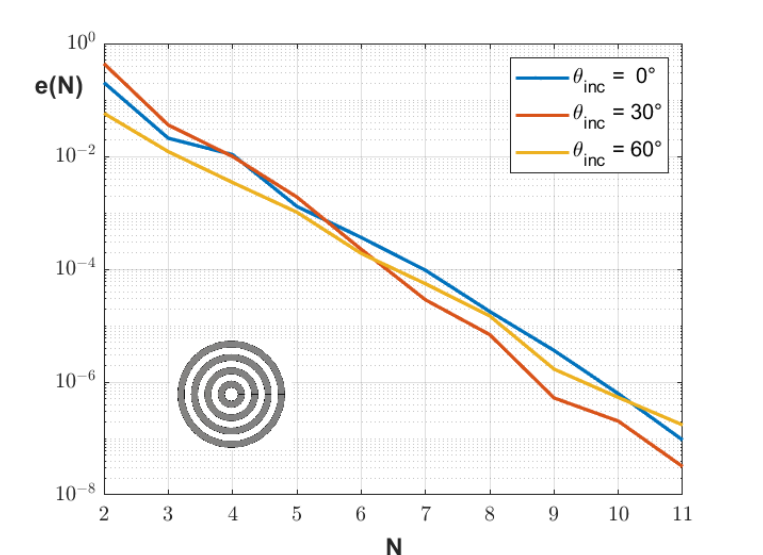
Figure 3. Plot of the error for the geometry #2 of Table 1 (sketched in the inset) for TE incidence and different incidence angles θ inc